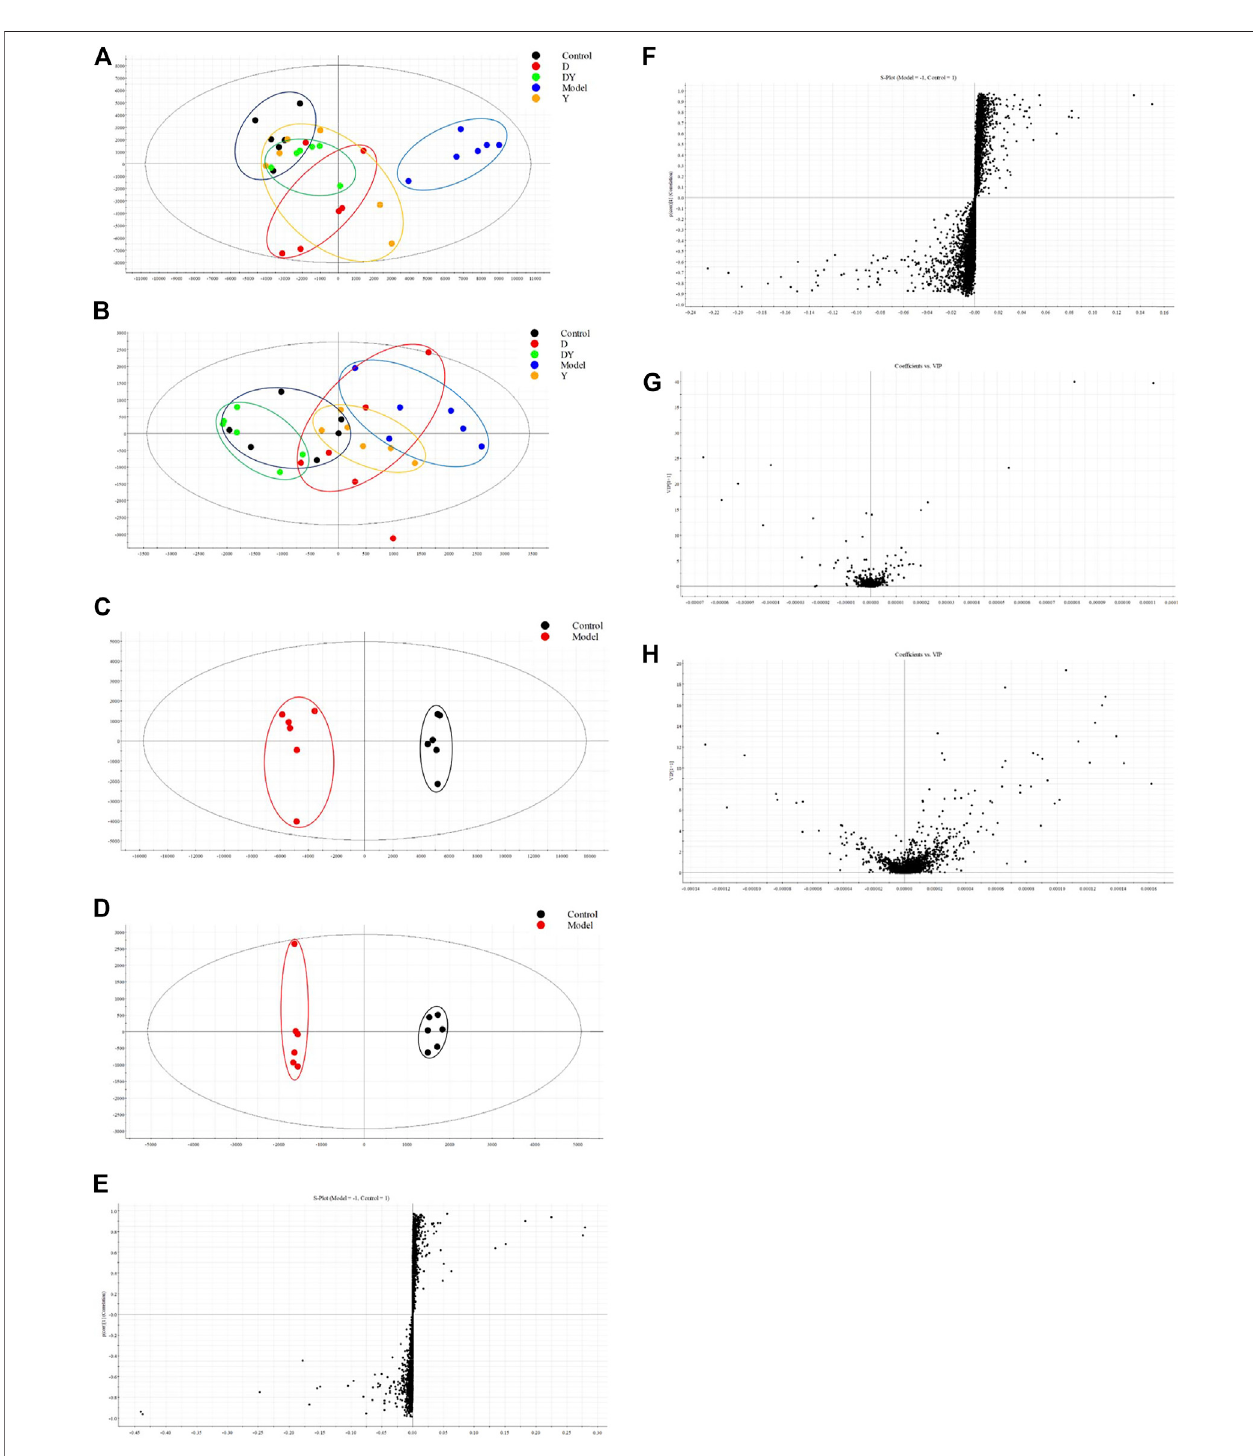
FIGURE 5 | PCA score plots of serum metabolic pro fi le in positive (A) and negative (B) ESI modes. OPLS-DA score plots of serum metabolic pro fi le in positive (C) and negative (D) ESI modes. S-plots of serum metabolic pro fi le in positive (E) and negative (F) ESI modes. VIP-plots of serum metabolic pro fi le in positive (G) and negative (H) ESI